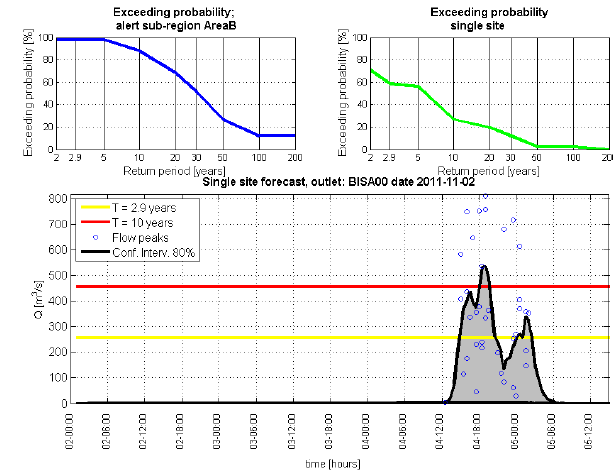
Fig. 4. Results of the operational probabilistic flood forecasting chain with the subjective precipitation forecast as meteorological input – Bisagno creek near the mouth (90km 2 ) . The lower panel shows the 80% confidence intervals of forecast discharge and the forecast peak flows. On the x-axis, the UTC time is reported. Note that the lower confidence bound is nearly zero. The top right panel shows the exceedance probability of the flow with return period T as function of T for the single site approach (Bisagno catchment). For purposes of comparison, the top left panel shows the exceedance probability of the flow with return period T in function of T for the multi-catchment approach in the alert sub-region containing the Bisagno catchment.